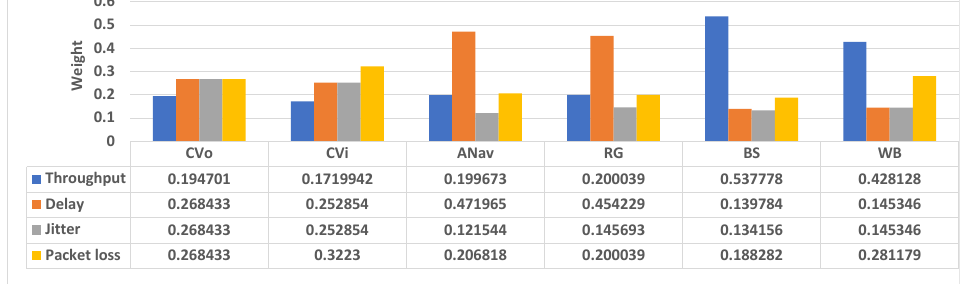
Figure 5. The FANP weights used for the estimation of Q estimated m , u ( t )